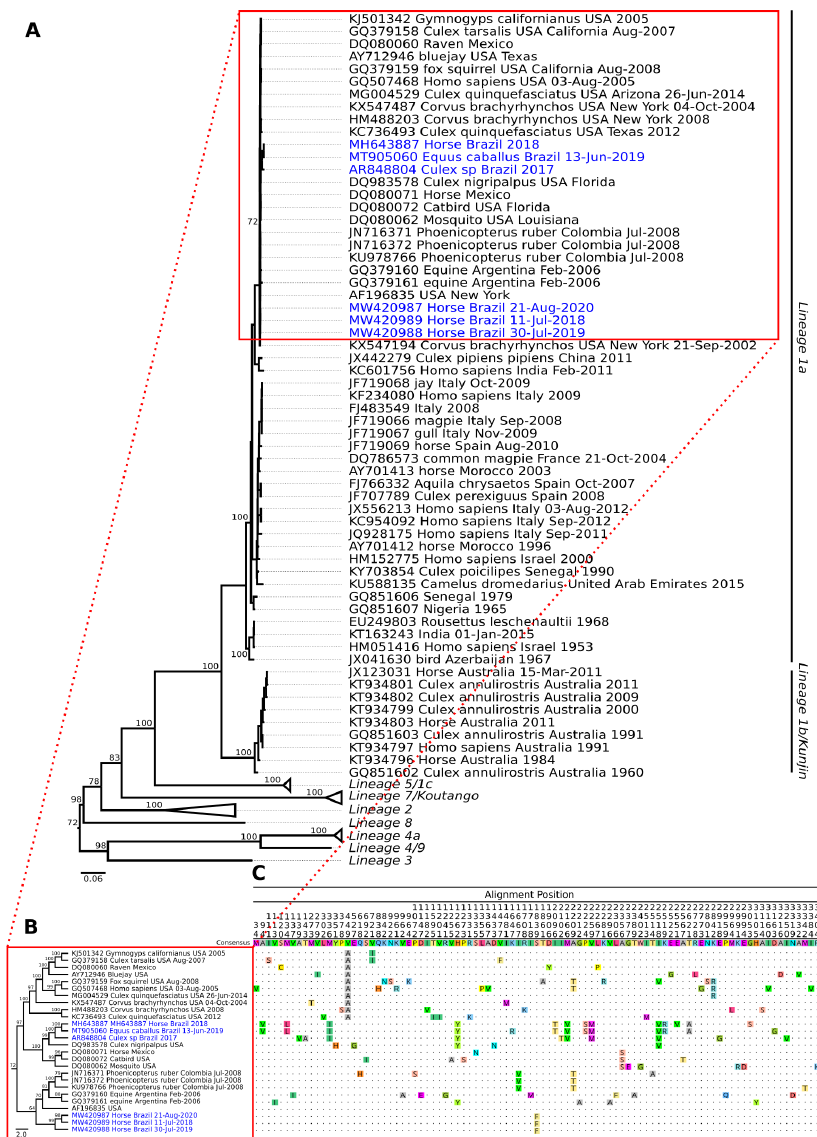
Figure 5. Phylogenetic tree of different WNV strains, including an isolate obtained from mosquitoes of the genus Culex spp. in Brazil. ( A ) Using the maximum likelihood (ML) method based on the complete nucleotide sequences of the polyprotein and using the GTR matrix as the best model for nucleotide substitution. Phylogenetic lineages are labeled in different clade colors. The numbers at each main node of the tree correspond to the bootstrap values in percent (1000 replicates). The scale bar corresponds to the nucleotide divergence per site between sequences. Highlighted in blue are the strains identified in Brazil. ( B ) Monophyletic clade of different strains 1a including those from Brazil. ( C ) Aminoacidic alignment of the polyprotein including only the non-synonymous